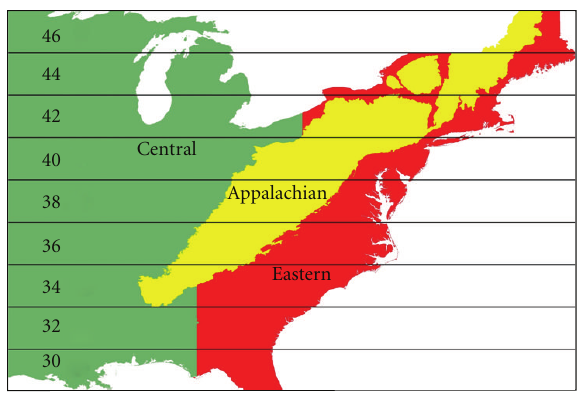
Figure 1: Our study area (29–47 ◦ N, 67–95 ◦ W) divided into three regions based on classifications used by the Breeding Bird Survey (http://www.pwrc.usgs.gov/bbs/) and the Environmental Protection Agency (Level III Ecoregions; http://www.epa.gov/wed/ pages/ecoregions/level iii